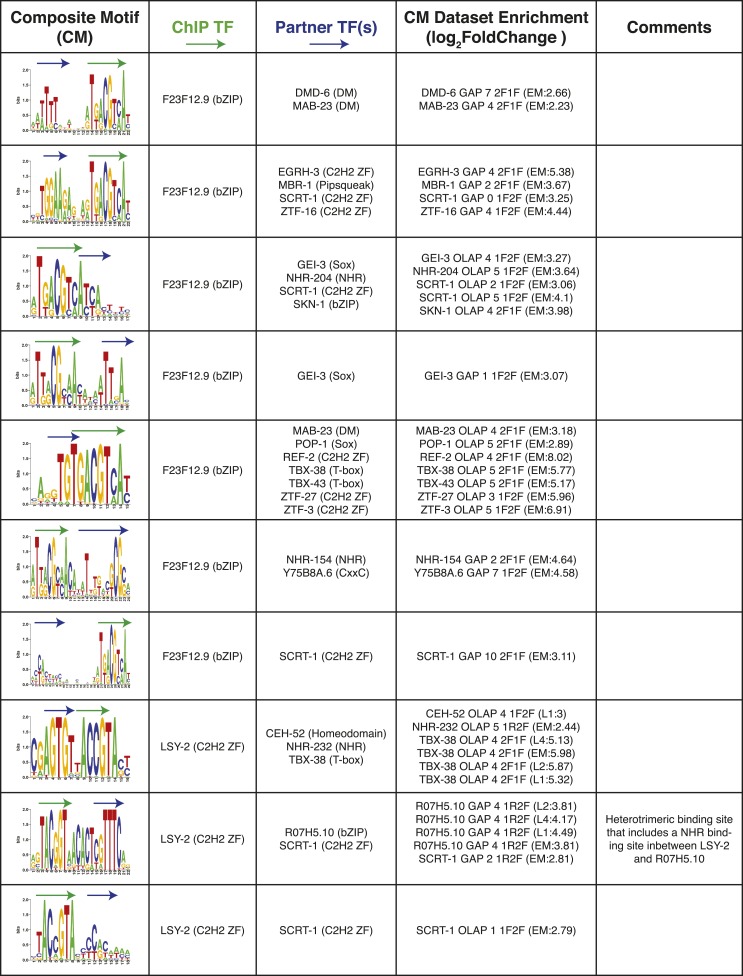
Summary of clustered CMs enriched in C. elegans ChIP-seq peaks (continued).CM-cluster centroids are shown for the enriched motifs. For each cluster, the ChIPed TF(s) and potential partner TF(s) are listed along with information about motif overlap (OLAP), spacing (GAP), and enrichment. Colored arrows over motif indicate high-information content portions of either factor.